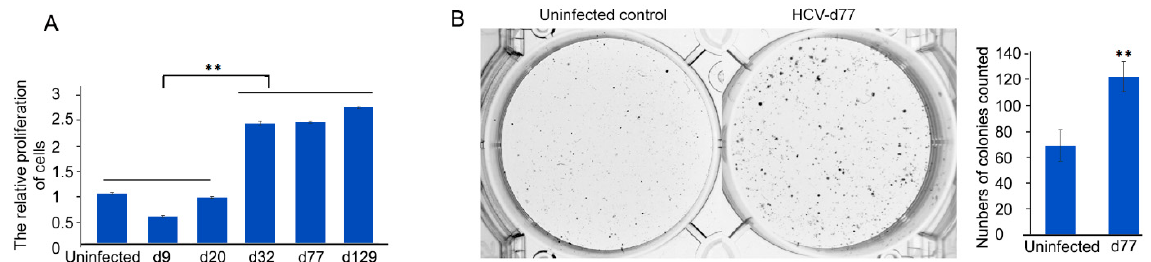
Figure 3. Increased cell proliferation and colony-forming ability in chronic HCV infection. ( A ) HCV-infected cells at the indicated time points post-infection (d9, d20, d32, d77, d129) and uninfected cells were plated at densities of 7500 cells/well in 96-well plates and cultured for 48 h. Cell proliferation was determined by MTT (3-(4,5-dimethylthiazol-2-yl)-2,5-diphenyltetrazolium bromide) assay. Results were calculated on data of triplicate experiments. Graph showed quantification of cell proliferation, ** p ≤ 0.01. ( B ) Chronic HCV-infected cells on day 77 (d77) after HCV infection and uninfected cells with the same passage number of chronic infected cells were plated at densities of 7500 cells/well in 6-well plate and cultured for 10 days. The visible colonies were fixed and stained and counted. Graph showed the quantification of colonies (mean ± SD, n = 3), ** p ≤ 0.01.